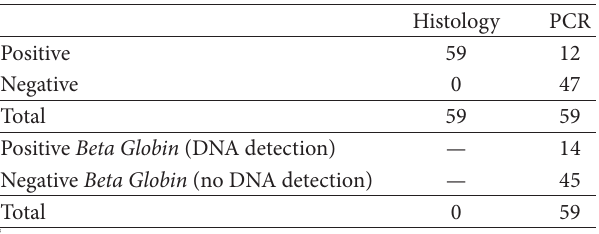
T 3: Comparison between PCR and histology test in paraffin biopsy